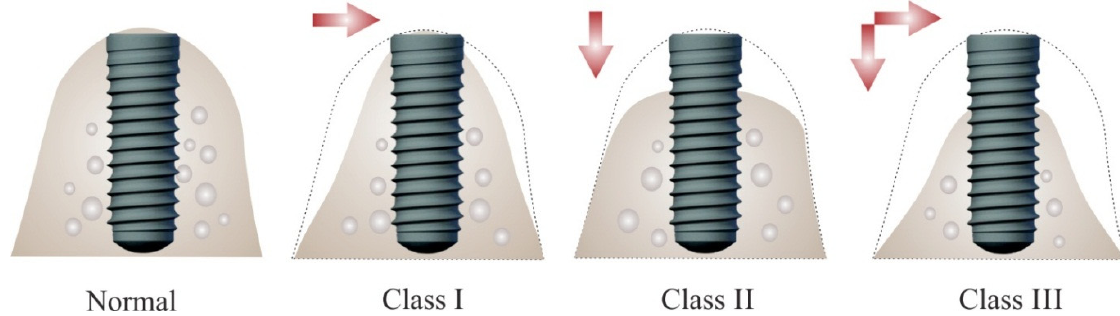
Figure 1. Bone volume insufficiency for implant placement. In Siebert class I ridge defects there is horizontal bone loss with adequate height, which leads to insufficient bone volume for successful placement of regular diameter implants. In class II there is vertical bone loss with adequate width, which leads to insufficient bone volume for proper positioning of regular length implants in correct prosthetic corono-apical position. In class III there is vertical and horizontal bone loss that prevents placement of successful implants in all spatial